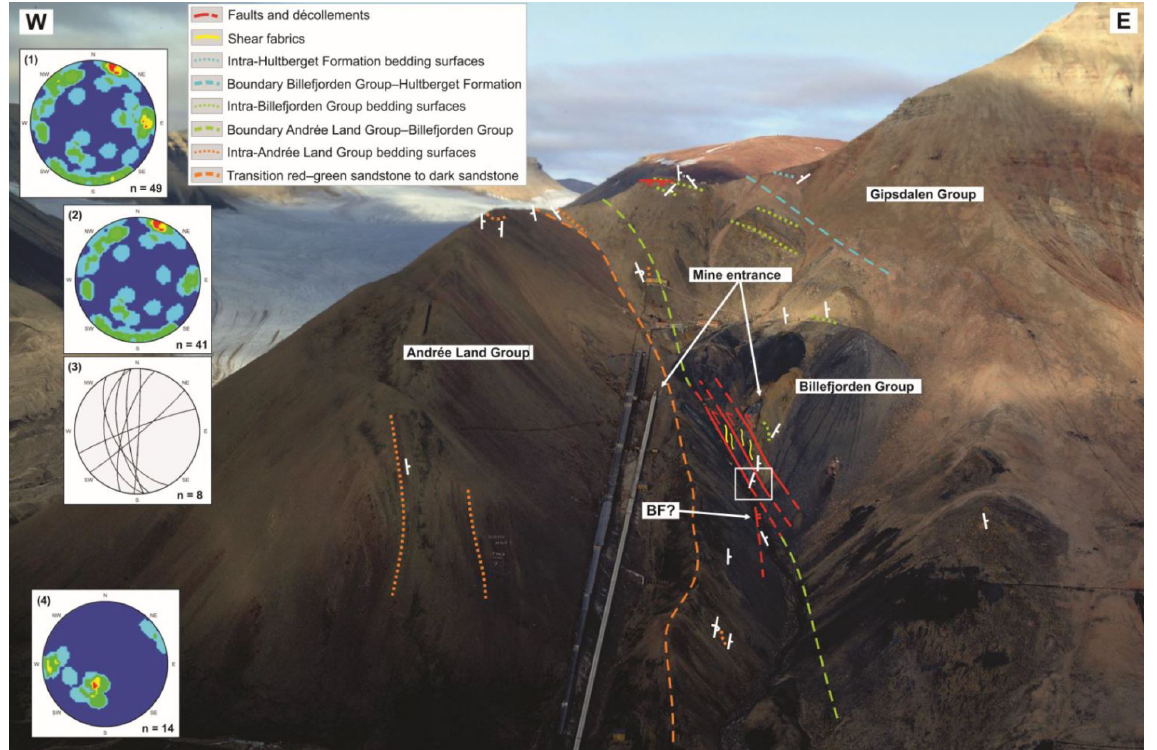
Figure 3. Aerial photograph of the Pyramiden coal mine locality showing intensely folded (dotted orange lines) Lower Devonian rocks in the west juxtaposed against clastic- and coal-rich uppermost Devonian–Mississippian sedimentary rocks of the Billefjorden Group, which are overlain by Pennsylvanian–lower Permian strata of the Gipsdalen Group in the east. Dashed lines represent lithostratigraphic transitions. Dotted lines represent bedding surfaces as seen in the photograph, whereas white symbols indicate a bedding trend and dip in map view (see Fig. 4a). Note the Z-shaped fabrics of uppermost Devonian–Mississippian sedimentary strata (yellow lines) along potential bedding- parallel décollements (red lines) near the boundary between Lower Devonian and uppermost Devonian–Mississippian sedimentary rocks. The white frame shows the location of Fig. 4b. Lower-hemisphere Schmidt stereonets show (1) contoured poles of fracture surfaces in the uppermost Devonian–Mississippian Billefjorden Group (red indicates high and blue low density), (2) contoured poles of fracture surfaces within sandstone units of the Billefjorden Group, (3) great circles of fracture surfaces within coaly shale- and coal-bearing units of the Billefjorden Group, and (4) contoured poles of fracture surfaces in Lower Devonian rocks. Photo by Åsle